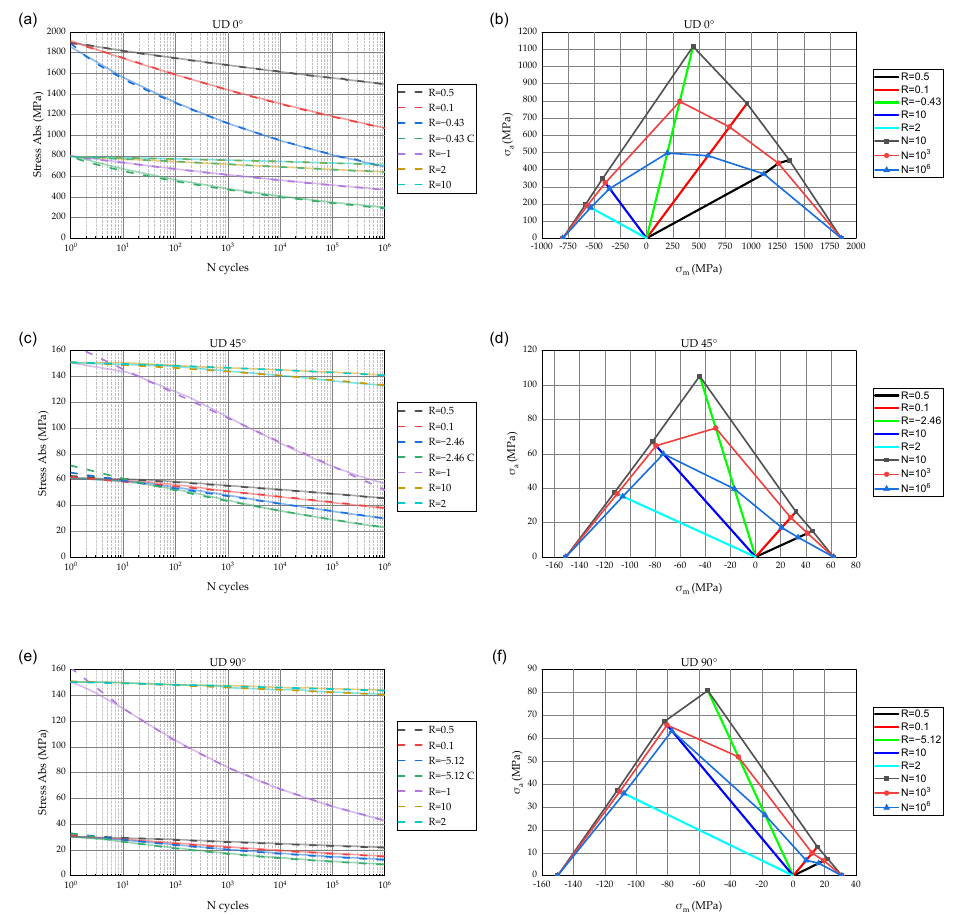
Figure 6. Approximated CLDs and S-N curves based on data [34] used in the FDM as lamina fatigue properties. S-N curves: ( a ) UD 0°, ( c ) UD 45°, ( e ) UD 90°. The CLDs: ( b ) UD 0°, ( d ) UD 45°, ( f ) UD 90°.